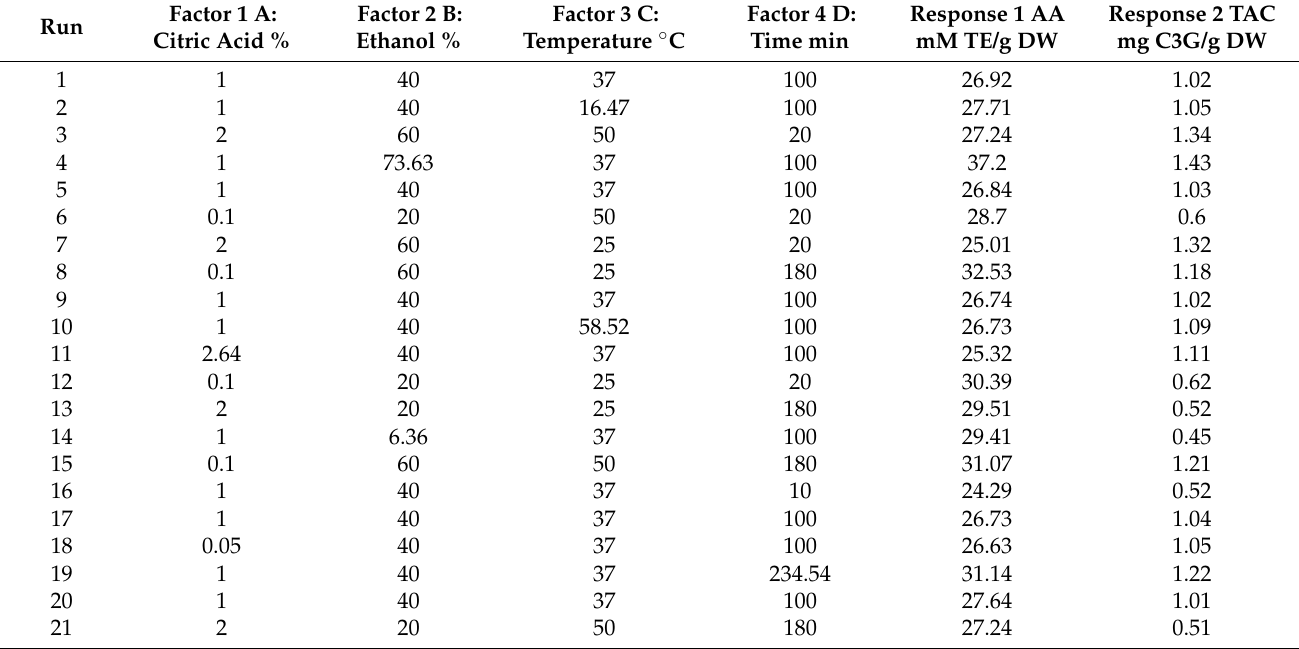
Table 2. Actual values of the principal variables analyzed in the CCD